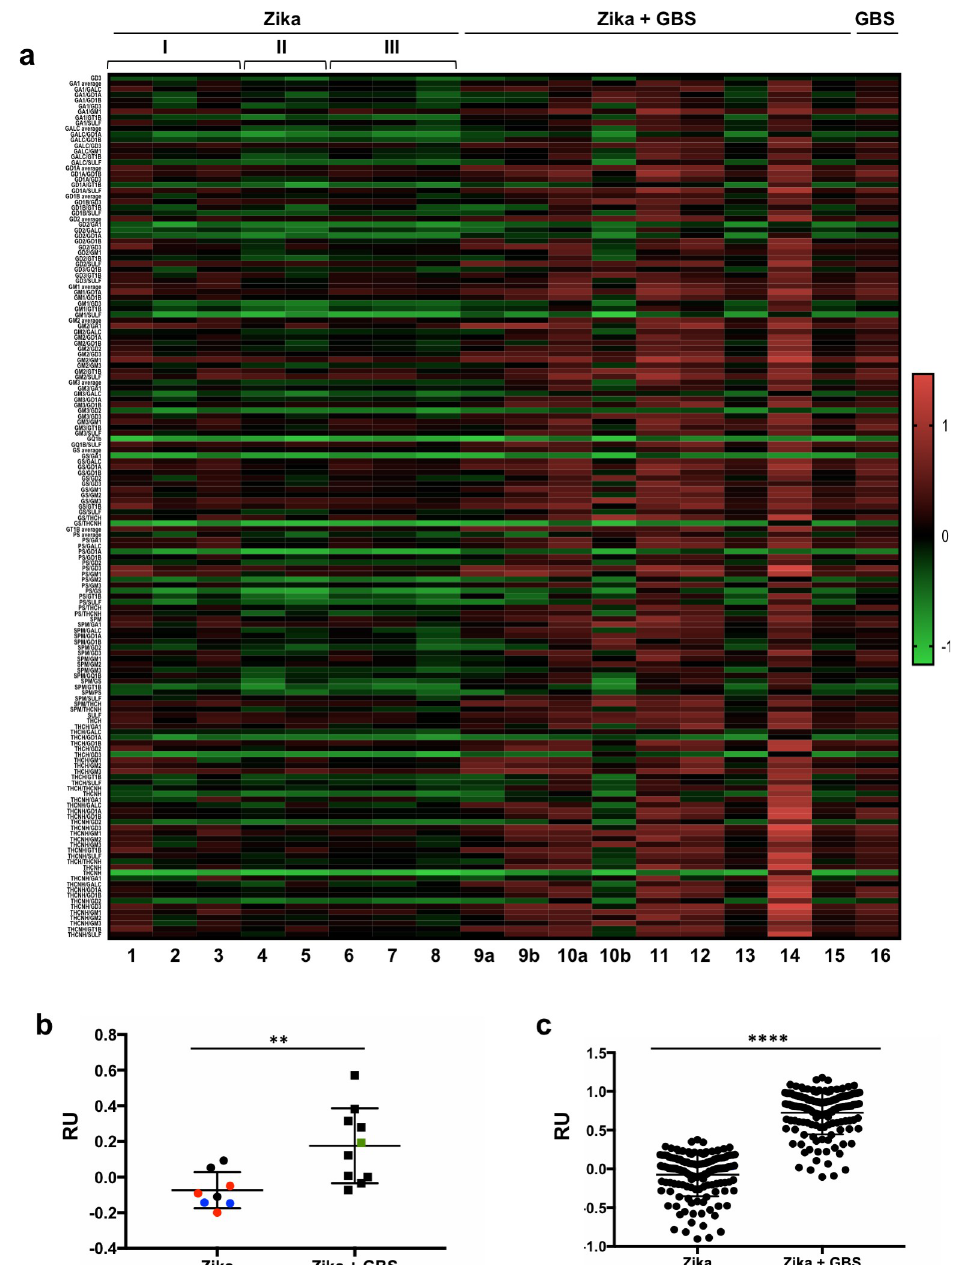
Fig 1. Reactivity of plasma samples from Zika patients with or without GBS. ( a ) Heatmap of antibody reactivity to single lipids and lipid combinations. Results from plasma of patients with uncomplicated Zika (acute (I: patients 1–3) or 4 months after the onset of symptoms (II: patients 4–5), with Zika infection and encephalitis (III: patients 6–8), with Zika infection and GBS (patients 9–15; a and b indicate different time points of sampling for the same patient) or with GBS from unidentified etiology (patient 16). Antigen lipids used: sphingomyelin (SPM), phosphatidylserine (PS), sulfatide (SULF), globoside (GS), Trihexosylceramide (CTH-hydroxi fatty acid) (THCH), Trihexosylceramide (CTH non-hydroxy fatty acid)(THCHN), galactocerebroside (GALC), and the gangliosides GM1, GM2, GM3, GA1, GD1A, GD1B, GD2, GD3, GT1B and GQ1B. ( b ) Average of reactivity values for all lipids and combinations in samples from patients with Zika with or without GBS. Samples of plasma from patients with uncomplicated acute Zika (black circles), 4 months after the onset of symptoms from a Zika infection (blue circles), Zika with encephalitis (red circles) and Zika with GBS (black squares). A sample of plasma from a patient with GBS but no Zika infection (unidentified etiology) (green square) was not considered in the average. ( c ) Average of reactivity values for each lipid and